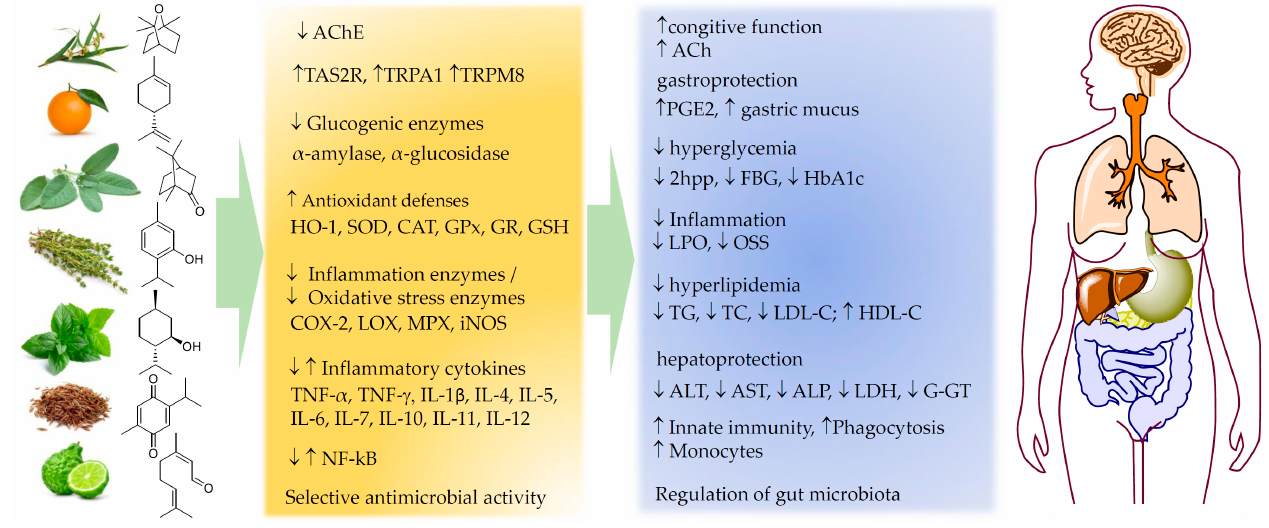
Figure 3. Summary of the biochemical interactions of EO components inducing physiological responses and ameliorating pathological conditions ( ↑ or ↓ , increase or decrease of initial condition). Supplementary Materials: The following supporting information can be downloaded at: